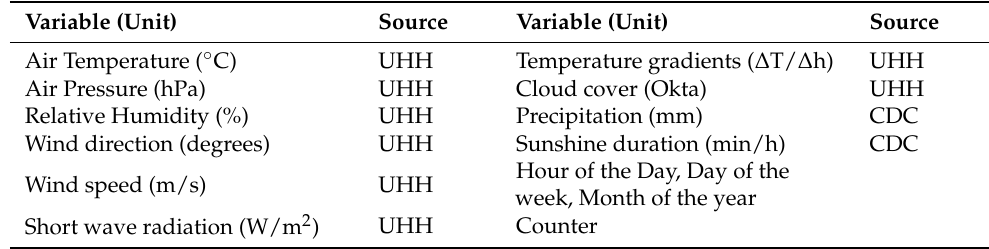
Table 1. Input variables used for the training of the model. Variable (Unit)